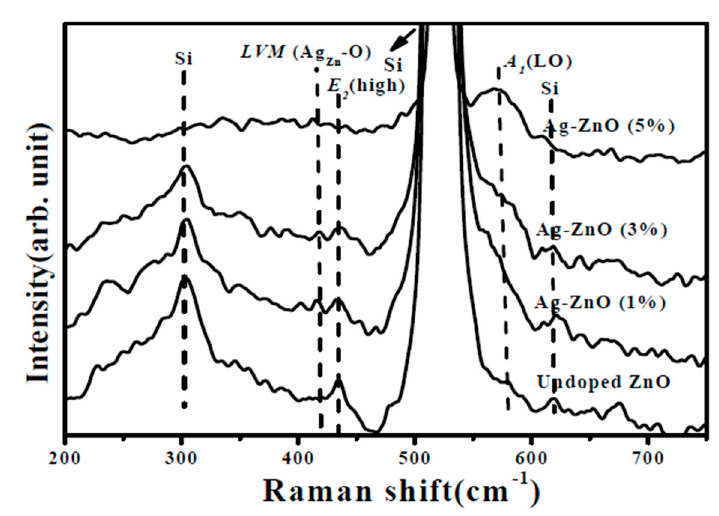
Figure 5. Raman spectra of the undoped ZnO and Ag-ZnO co-sputtered films annealed at 350 °C for 1 h under ambient air. Table 2. Peak position and the FWHM of the ZnO (002) phase, as well as the corresponding crystalline size, D, for the undoped ZnO and the Ag-ZnO co-sputtered films annealed at 350 °C for 1 h under ambient air.